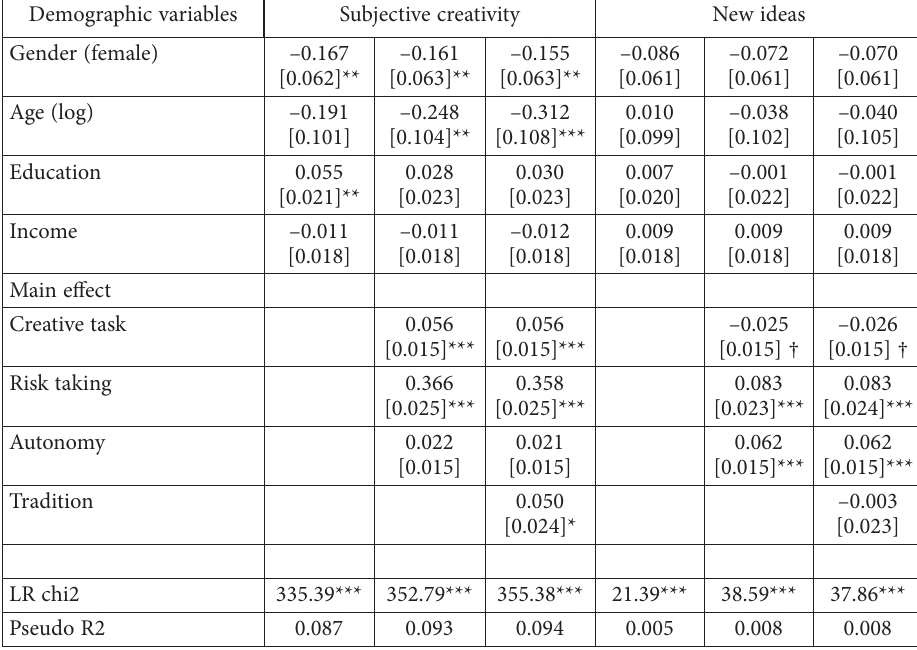
Table 3. Ordered probit regression exploring the relationship among variables of main variable and subjective creativity and new ideas (source: created by authors) Demographic